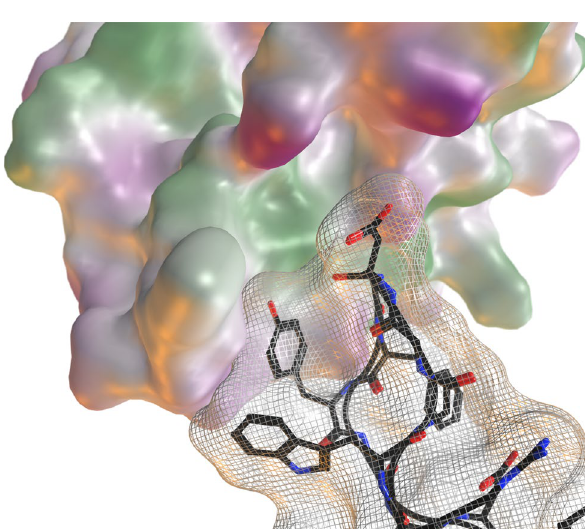
Figure 2. Examination of the bH1 epitope on VEGF (PDB ID: 3BDY) reveals empty space close to H3. The VEGF antigen is shown as a surface, the bH1 antibody is shown with a light-grey mesh/ribbon, except the H3 which is shown with black tube and ball-and-stick